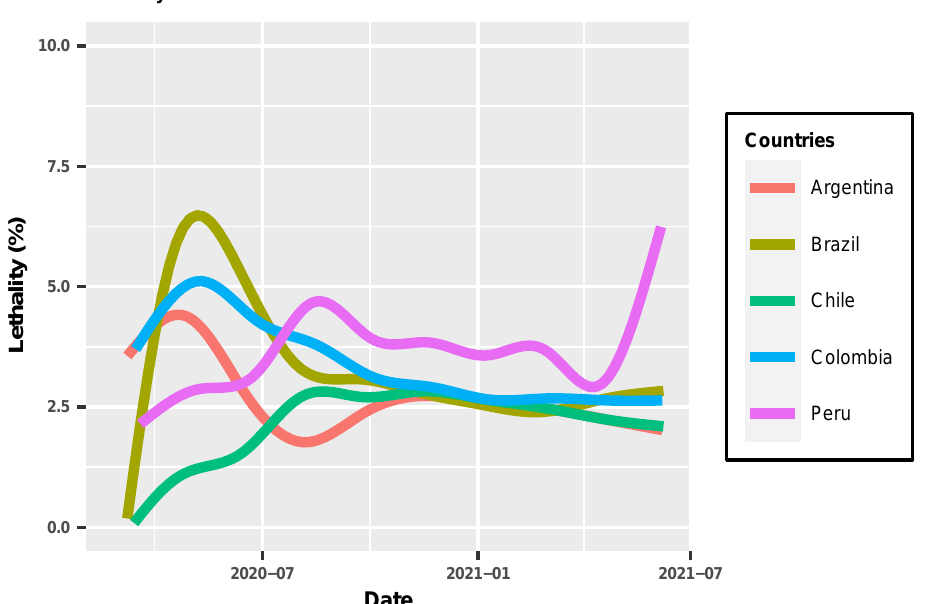
Figure 5. Series of lethality rates (%) for five countries in South